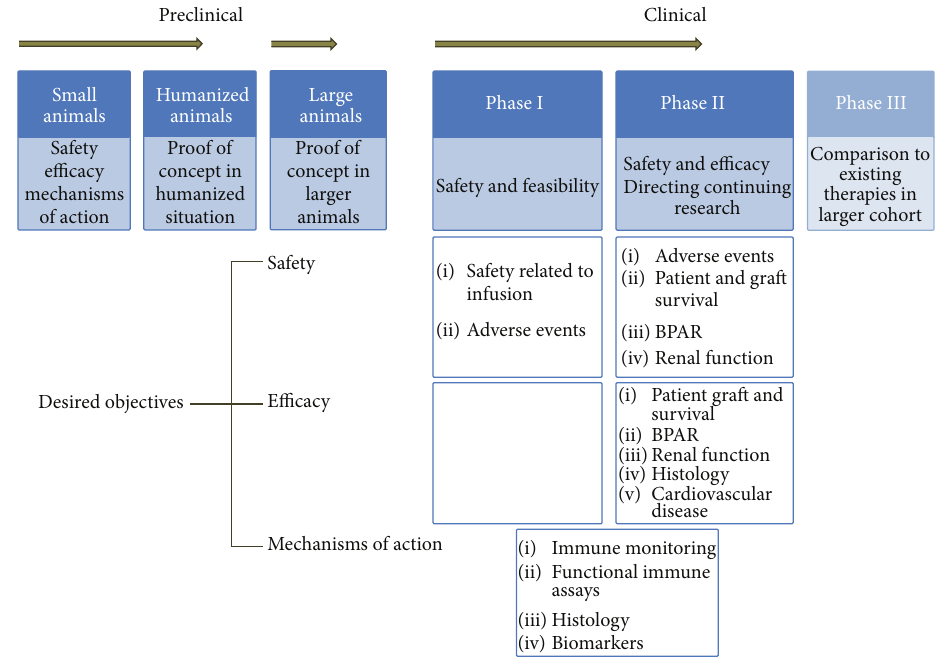
Figure 1: Desired objectives in clinical studies with MSCs in renal transplantation. Preclinical studies with MSC in the transplant setting start with small animals to investigate safety, efficacy, and mechanisms of actions. Then studies move on to prove the concept in humanized animals and larger animals. Human phase I studies address safety and feasibility in a low number of patients and determine the direction of further research. Phase II studies focus on both safety and efficacy parameters, which include patient and graft survival, BPAR, renal function, histology, and cardiovascular disease. Surrogate markers, such as immune monitoring and functional immune assays, are used to determine mechanisms of action. BPAR: biopsy proven acute